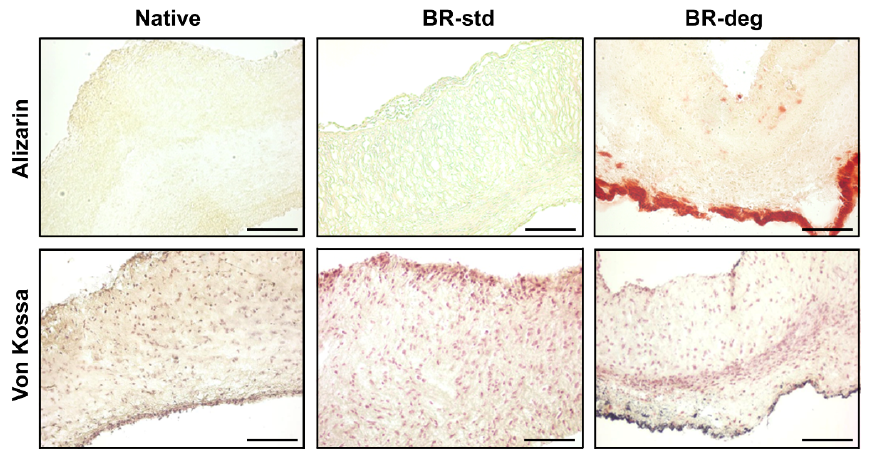
Figure 3. Ex vivo cultivation in pro-degenerative conditions led to biomineralization . Cross-sections of native aortic valve leaflets (Native) and leaflets cultivated under standard (BR-std) or pro-degenerative conditions (BR-deg) were stained with Alizarin red (upper panel) and von Kossa (lower panel). Alizarin red staining (red) and von Kossa staining (black) indicating biomineralization, were detected after cultivation in BR-deg, but not in BR-std or native control. Representative pictures of eight replicates were chosen. Bars: 100 µm.